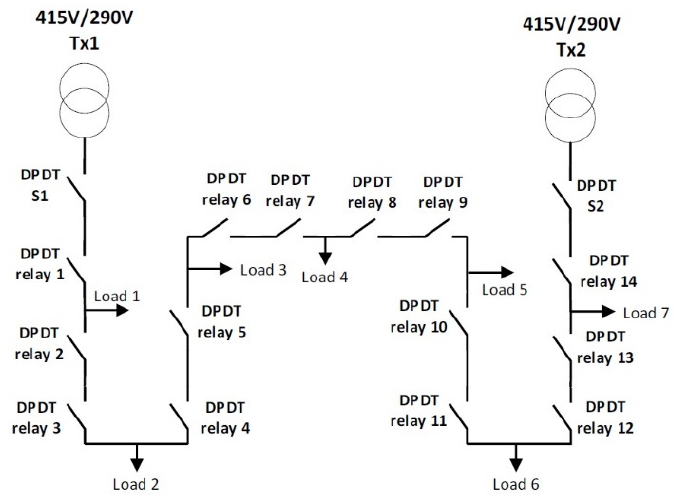
Figure 4. Design of the hardware prototype.